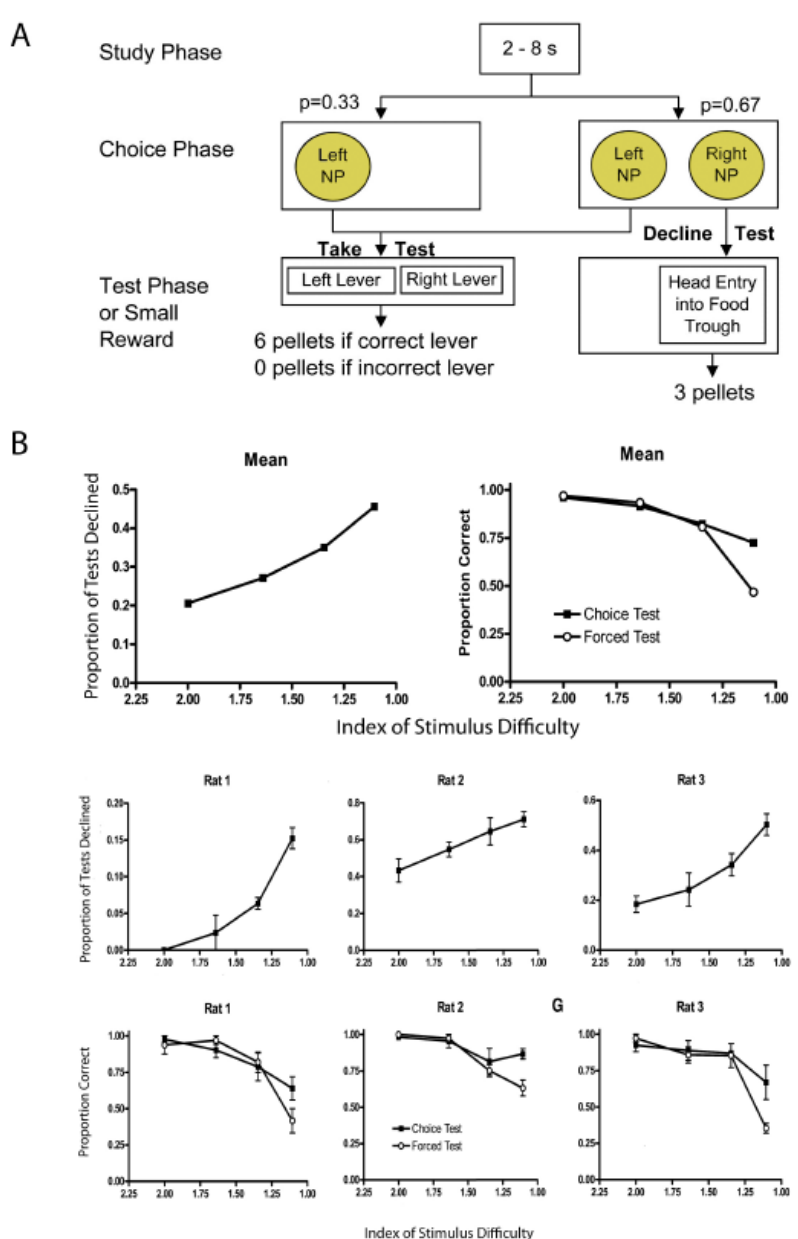
Figure 2 . Schematic representation of design of study and data for rats. A. Procedure (left panel; Foote & Crystal, 2007): After presentation of a brief noise (2-8 s; study phase), a choice phase provided an opportunity for taking or declining a duration test; declining a test produced a guaranteed but smaller reward than was earned if a test was selected and answered correctly (test phase). The yellow shading indicates an illuminated nose-poke (NP) aperture, used to decline or accept the test. B. Data (Foote & Crystal, 2007): Performance from three rats (bottom panels) and the mean across rats (top panels). Difficult tests were declined more frequently than easy tests; difficulty was defined by proximity of the stimulus duration to the subjective middle of the shortest and longest durations). The decline in accuracy as a function of stimulus difficulty was more pronounced when tests could not be declined (forced test) compared to tests that could have been declined (choice test). Error bars represent standard errors. (Adapted from Foote, A. L., & Crystal, J. D. (2007). Metacognition in the rat. Current Biology, 17, 551-555. © 2007 by Elsevier Ltd. Reprinted with